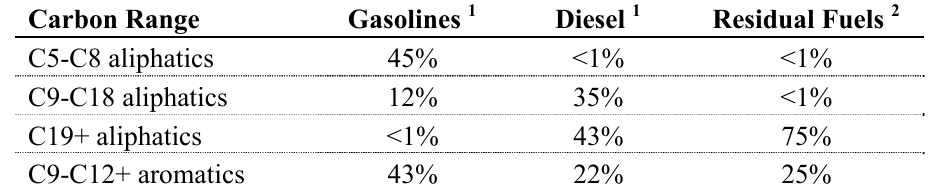
Table 2. Example carbon range makeup of non-BTEXN, TPH component of petroleum fuels (exact carbon range makeup of individual fuels will